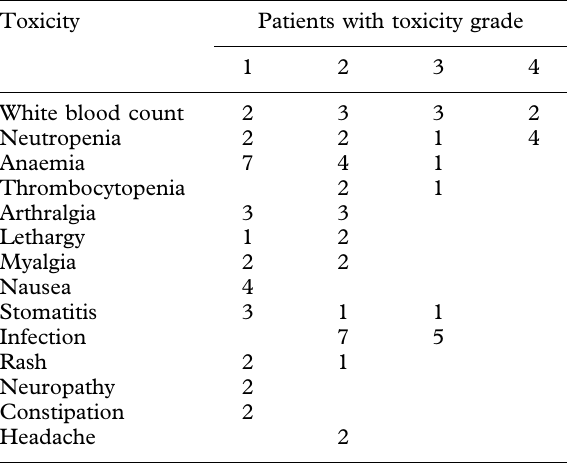
Table 2. Treatment-related toxicity Toxicity Patients with toxicity